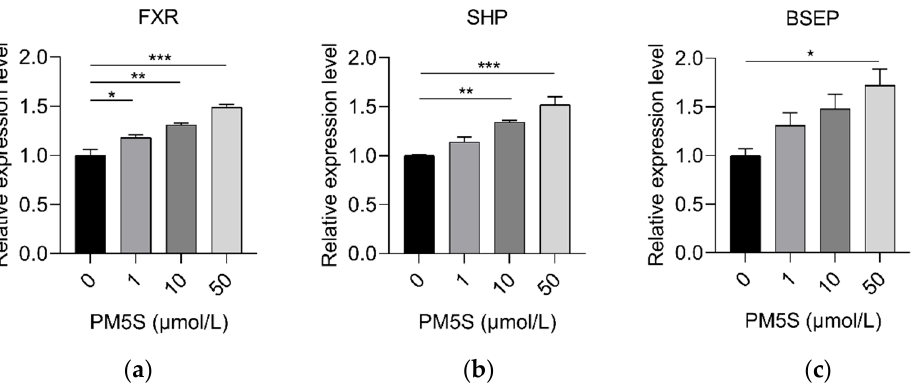
Figure 8. Relative expression of ( a ) FXR , ( b ) SHP , and ( c ) BSEP in pig primary hepatocytes with increasing doses of PM4S (0, 1, 10, and 50 μ mol/L), respectively. n = 3/group. Data are shown as means ± SE, * p < 0.05, ** p < 0.01, *** p < 0.001.